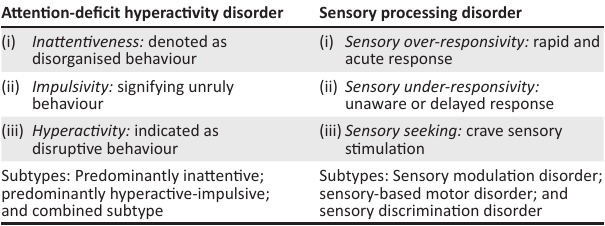
TABLE 1: Attention-deficit hyperactivity disorder characteristics and sensory processing disorder response regulation. Attention-deficit hyperactivity disorder Sensory processing